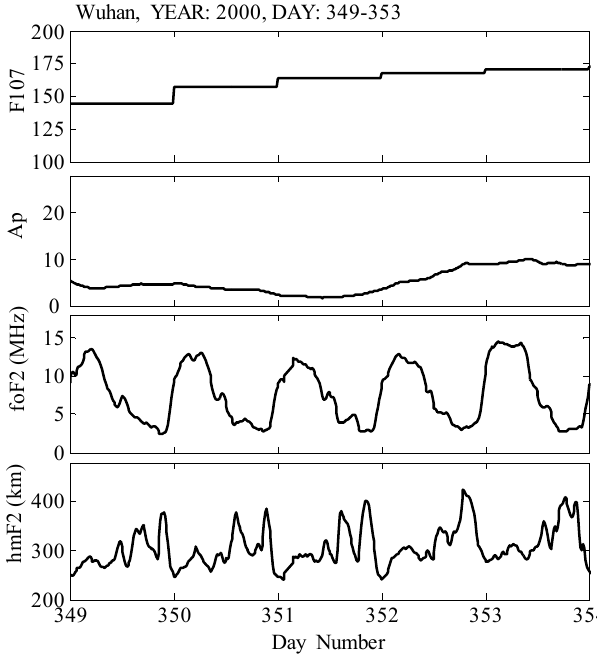
Fig. 4. Temporal variation of critical frequency, foF2, and peak height, hmF2, over Wuhan during days 349-353 of the year 2000. The two top panels show the solar 10.7cm flux index, F107, and the daily magnetic index, Ap.